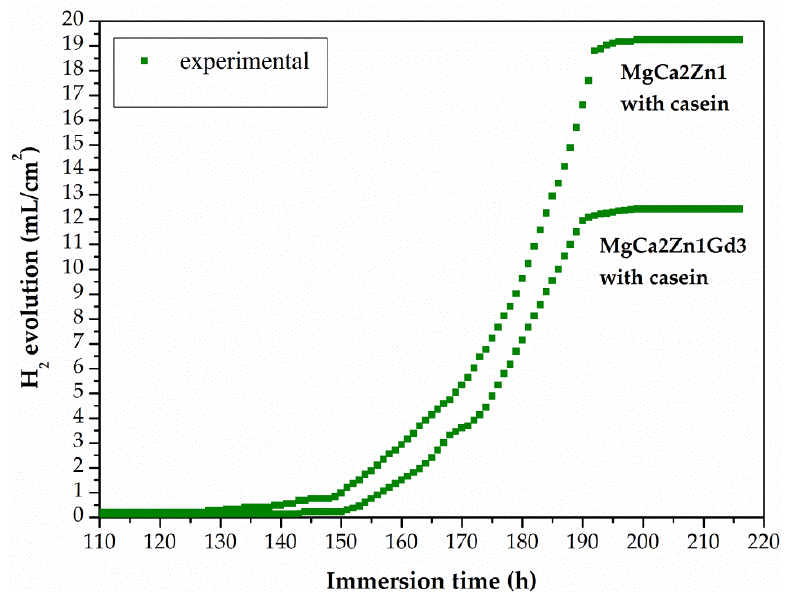
Figure 13. Volume of hydrogen evolution as a function of immersion time in Ringer solution at 37 °C during 216 h for the casein coatings applied to the MgCa2Zn1 and MgCa2Zn1Gd3 alloys.